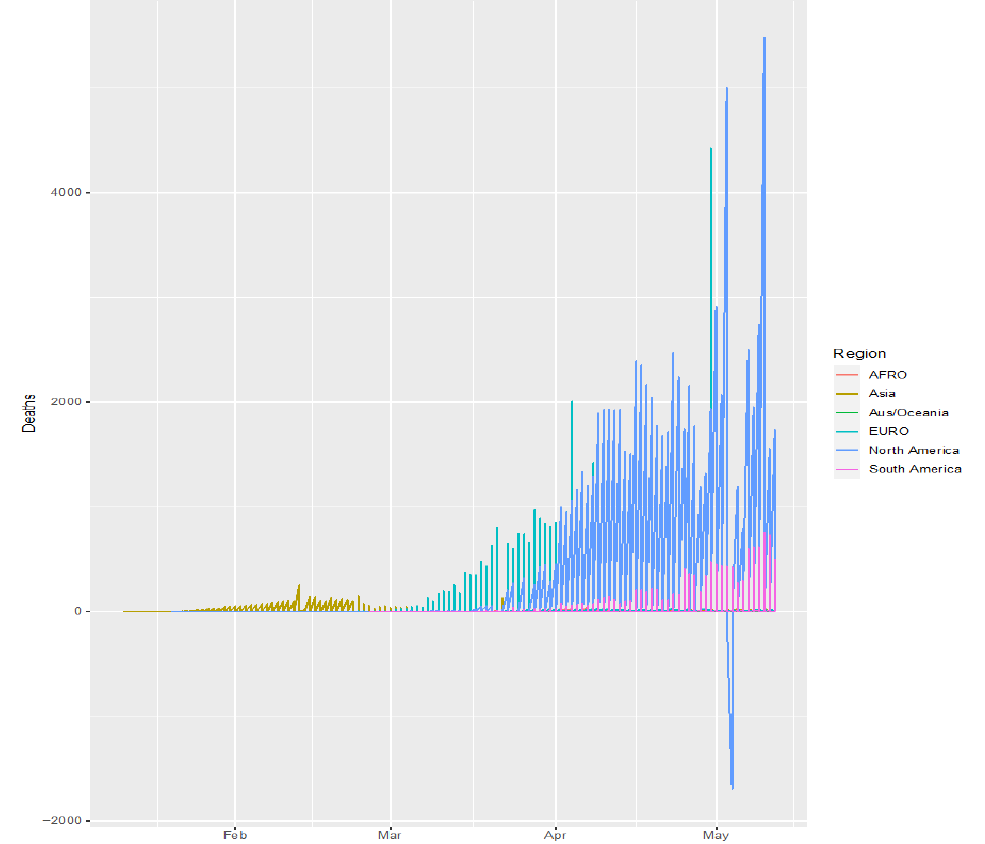
Fig. 1. Global simulation of COVID-19 mortality by